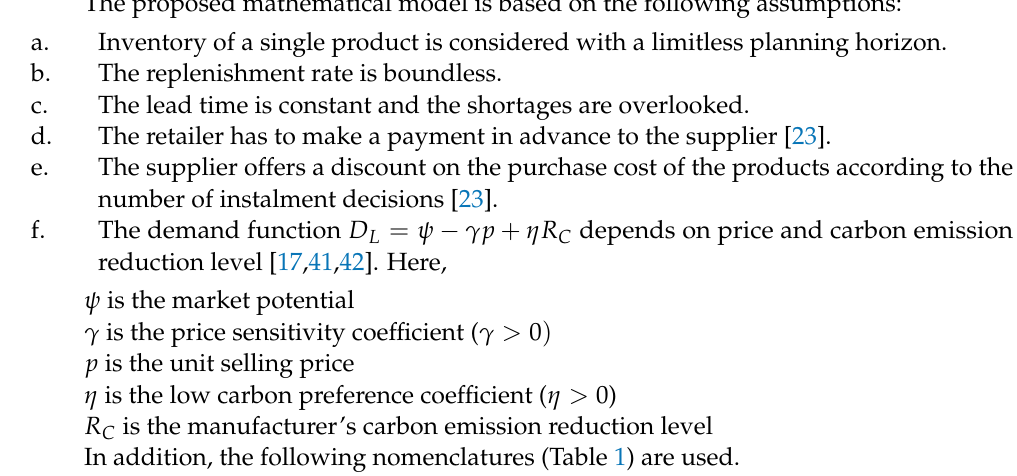
Table 1. Notation